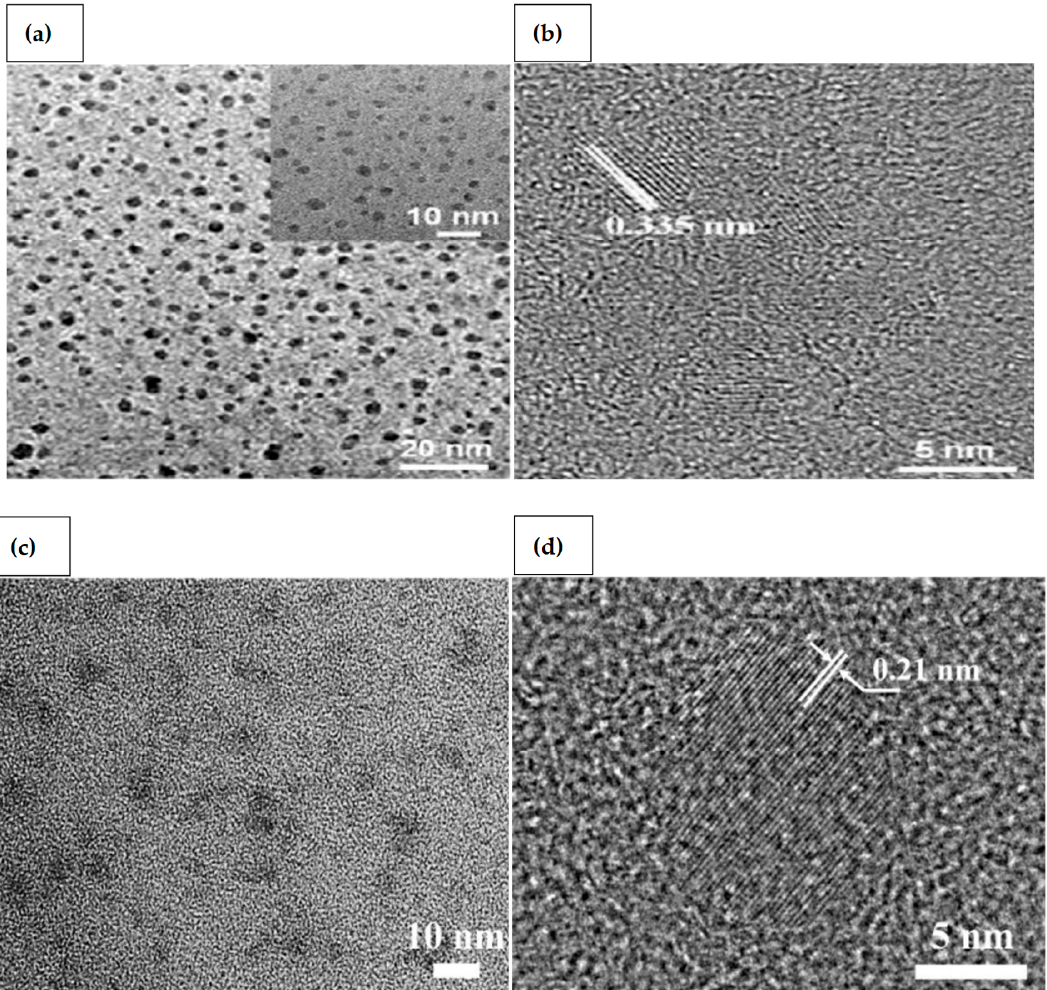
Figure 1. ( a ) TEM; ( b ) HRTEM image of GQDs (Adapted from the Ref. [31] with the permission of catalysts); ( c ) TEM; and ( d ) HRTEM image of CQDs (Adapted from the Ref. [32] with the permission of ACS Applied Materials and Interfaces).